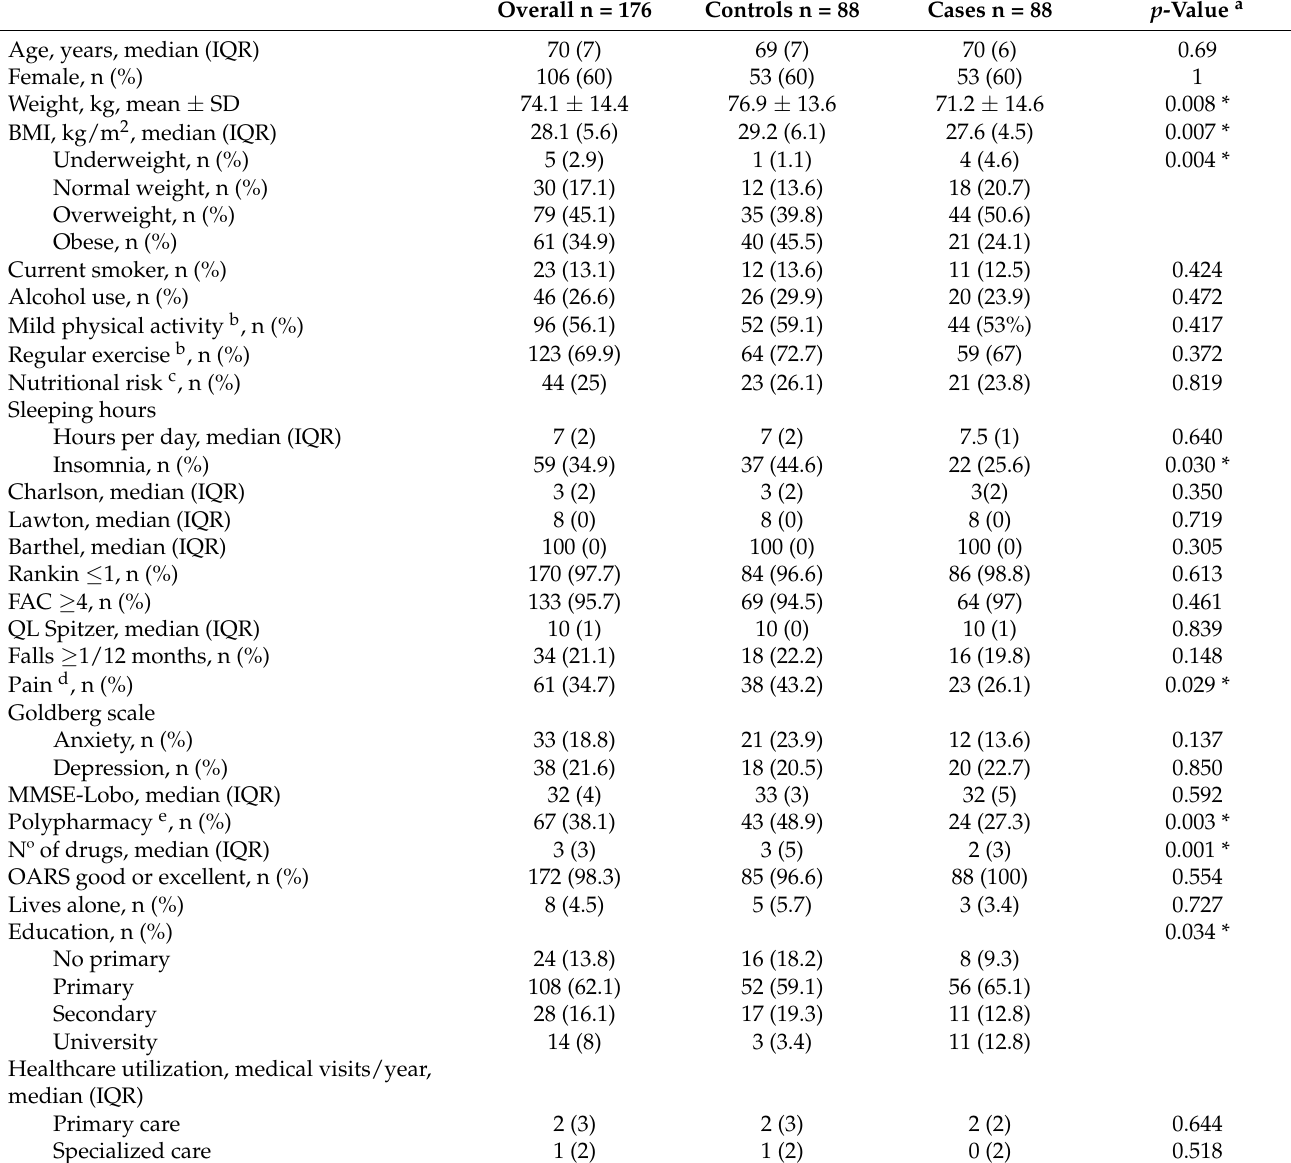
Table 1. Demographic, health, and functional